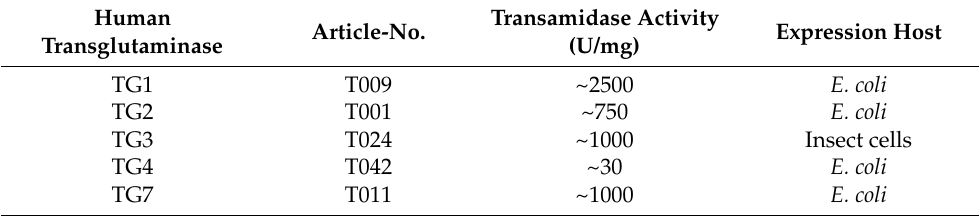
Table 2. Comparison of transamidase activity of human recombinant transglutaminases. Trans- amidase activities of TG1, TG2, TG3, TG4 and TG7 were collected from the Zedira GmBH (Darm-